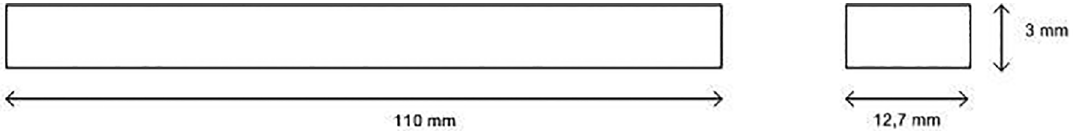
Figure 1. Test specimens based on ASTM D79 for flexural testing.